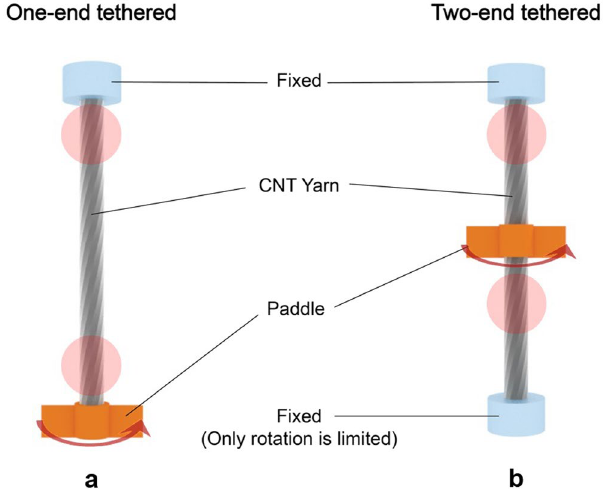
Figure 3. In situ torsional testing of CNT yarns. ( a ) One-ended tethered configuration, i.e., one end of the CNT yarn is fixed while twisting/untwisting operations are applied at the other end via a paddle. This configuration allows the CNT yarn to move along the yarn axis. ( b ) Two-ended tethered configuration, i.e., one end of the CNT yarn is fixed as in the one-ended tethered configuration while the other end is fixed to prevent rotation but allow movement along the yarn axis. In this configuration, twisting/untwisting operations are applied at the center part of the CNT yarn via a paddle. The red solid circles represent the area where the orientation changes of individual CNTs were measured using Raman